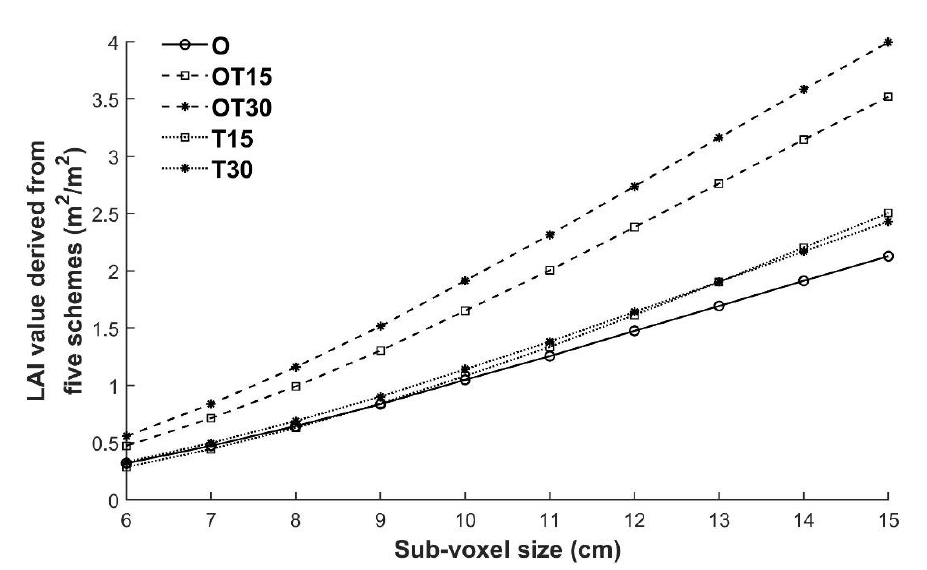
Figure 7. The distribution trend of average LAI of 72 plots derived from voxel model with differ- ent sub-voxel sizes (6 cm–15 cm, step is 1 cm).